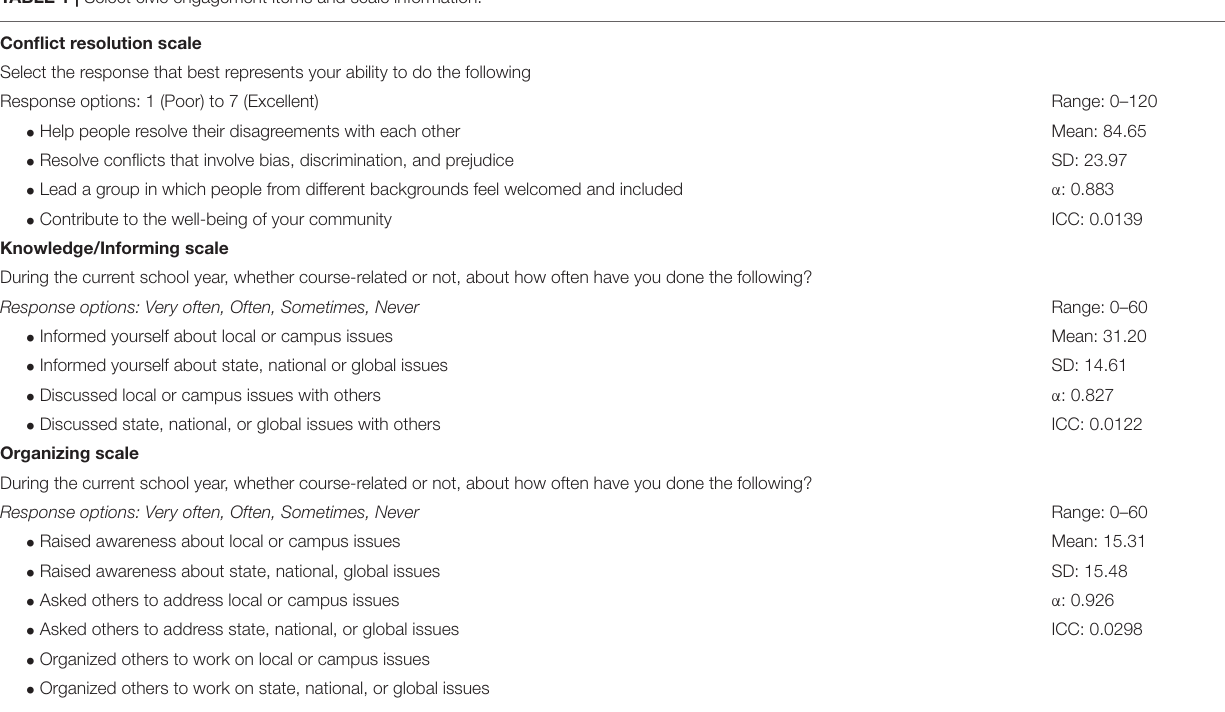
TABLE 2 | Student groups based on cluster analysis of civic engagement scales. Activists Non-active Allies